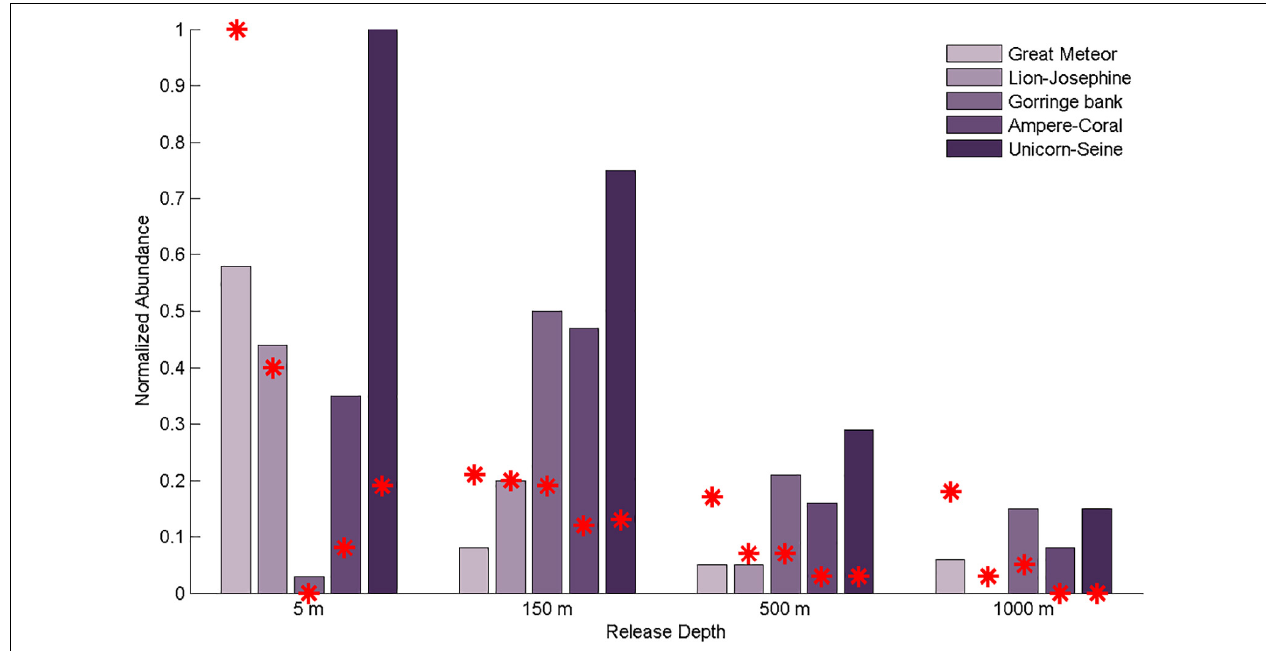
FIGURE 9 | Bar plot representing the captured particles per square kilometer, per sink box, by depth. The red stars represent the total number of captured particles per sink box. The sink boxes are arranged in descending order of sizes (i.e., Great Meteor, Lion-Josephine, Gorringe bank, Ampere-Coral, and Unicorn-Seine). Both datasets were normalized so as to be